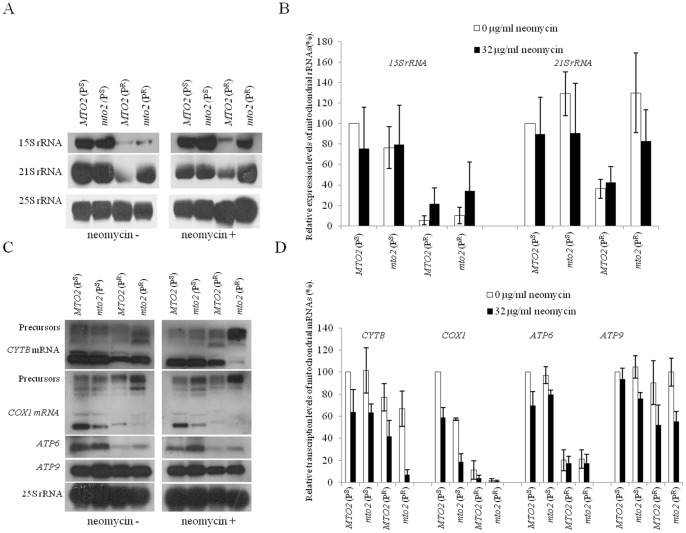
Northern blot analysis of transcription levels of mitochondrial genes.
A, northern blot analysis of mitochondrial 15S rRNA and 21S rRNA. The nuclear encoded 25S rRNA was hybridized as a internal control. B, quantitative analysis of mitochondrial rRNA transcription levels, where each calculation was based on three independent determinations of each RNA in each yeast strain. C, northern blot analysis of CYTB, COX1, ATP6 and ATP9. D, quantitative analysis of mitochondrial mRNA transcription levels.